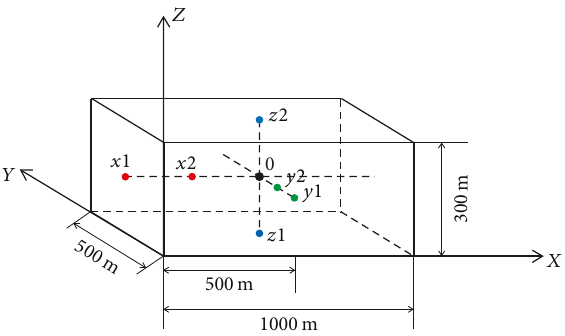
Figure 8: Locations of the seven observation points.